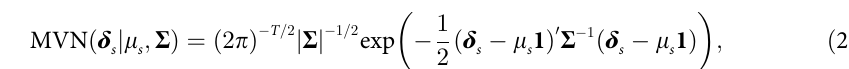
Fig 6. ^ g (colored line) and logit ð ^ y t each state on the logit scale.